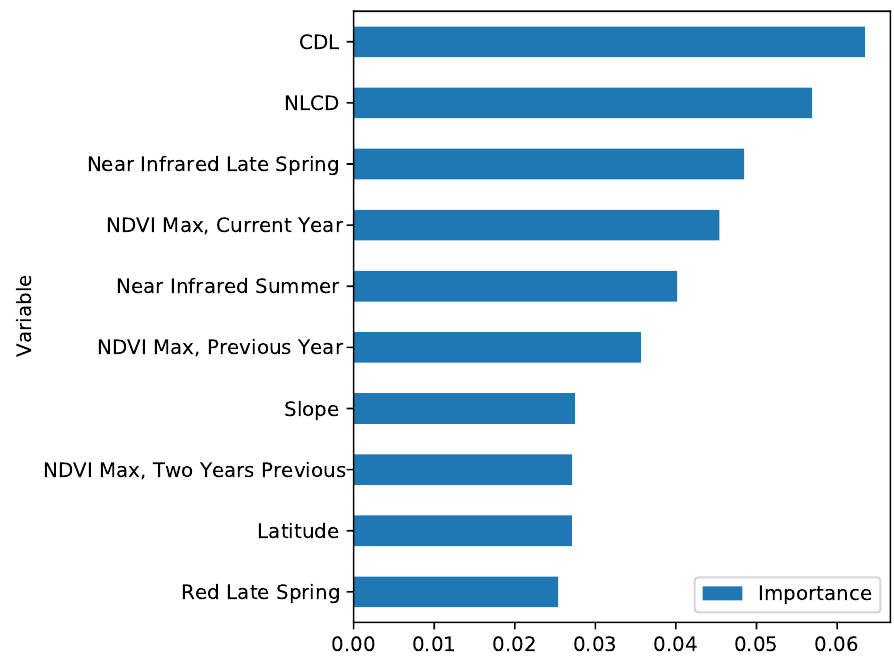
Figure 7. The fractional importance of the top 10 variables from the IrrMapper Random Forest model (0.40 accuracy contribution). Variable importance was calculated over ten iterations of model training using a total of 132 data